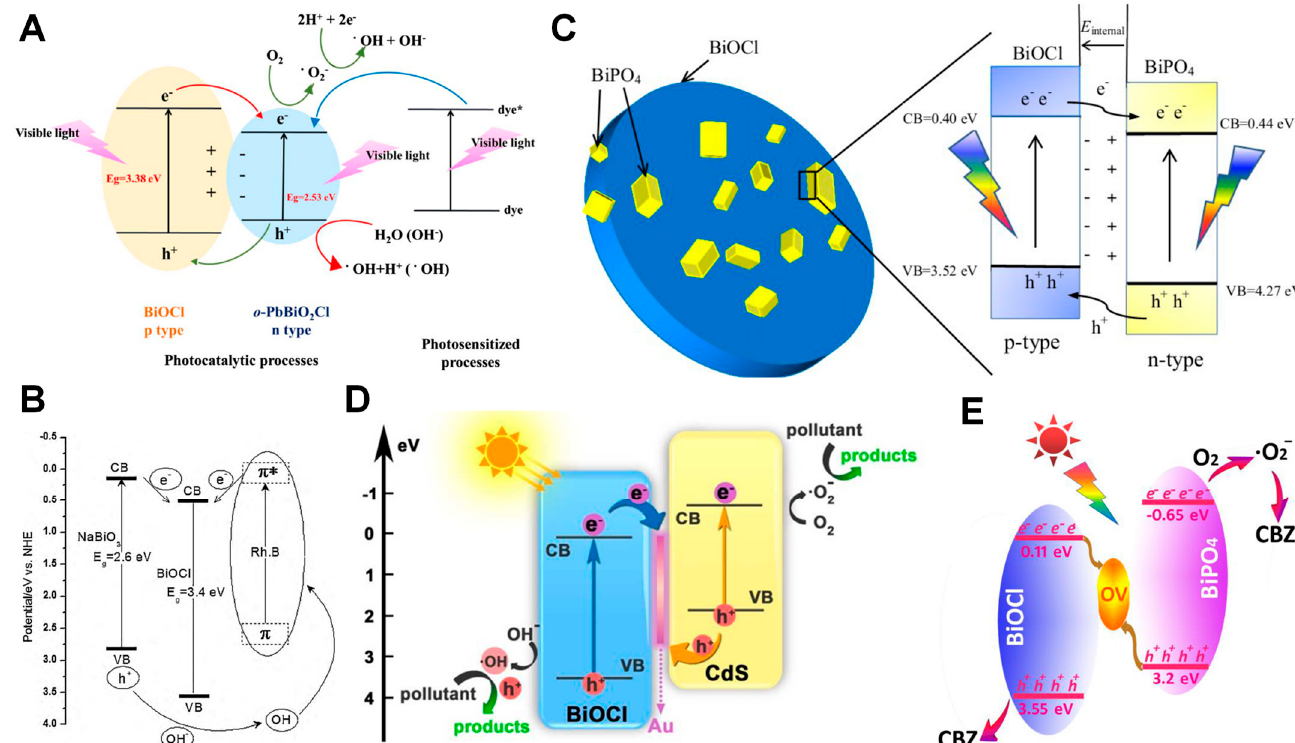
Figure 4. Scheme of various BiOCl-based heterostructures. ( A ) BiOCl-PbBiO 2 Cl type I heterostruc- ture. Reproduced with permission from Ref. [57], 2018, Elsevier. ( B ) BiOCl-NaBiO 3 type II het- erostructure. Reproduced with permission from Ref. [54], 2010, Elsevier. ( C ) BiOCl-BiPO 4 type II heterostructure. Reproduced with permission from Ref. [55], 2016, Elsevier. ( D ) BiOCl-Au-CdS Z-scheme heterostructure. Reproduced with permission from Ref. [60], 2017, American Chemical Society. ( E ) BiOCl-OV-BiPO 4 Z-scheme heterostructure. Reproduced with permission from Ref. [59], 2018,